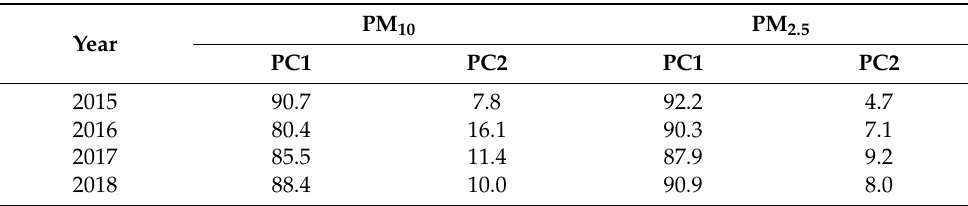
Table 4. Proportion of variance explained (in %) by pollutant and principal components (PC1 and PC2).